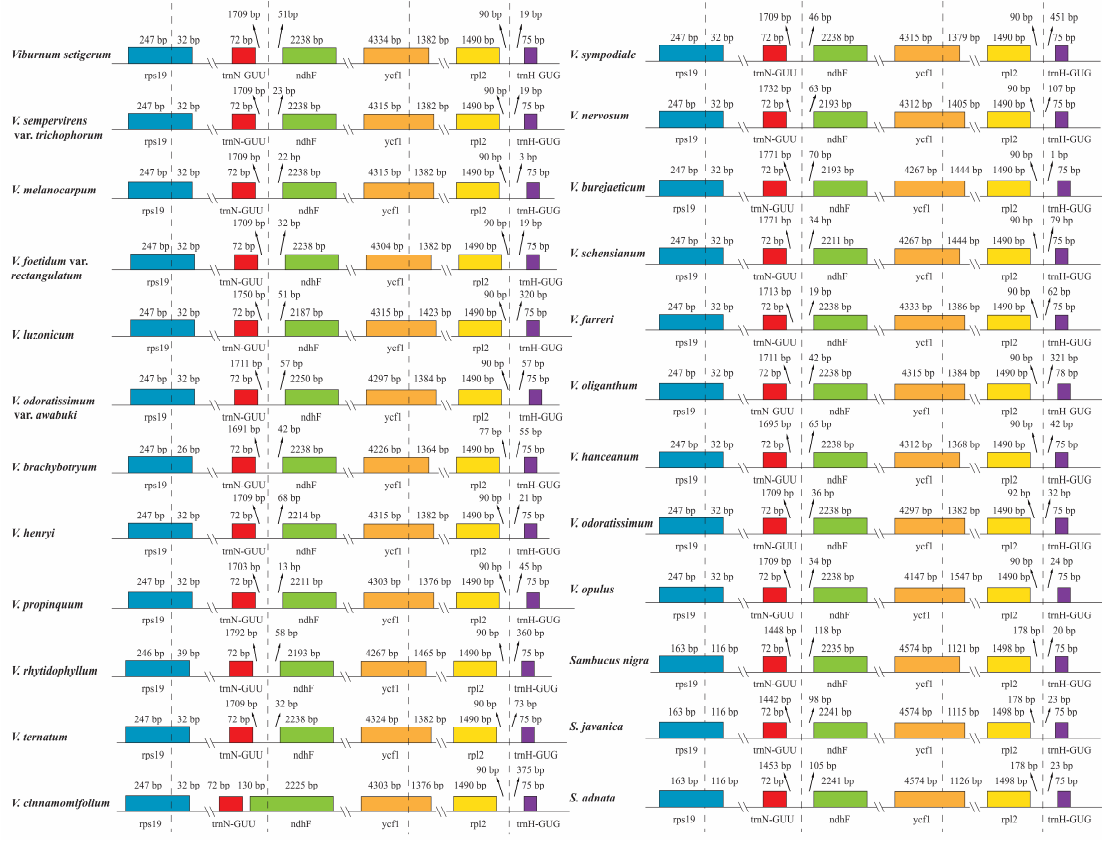
Figure 2. Comparison of the junctions between IRs and SSC/LSC regions for the 24 Adoxaceae species.